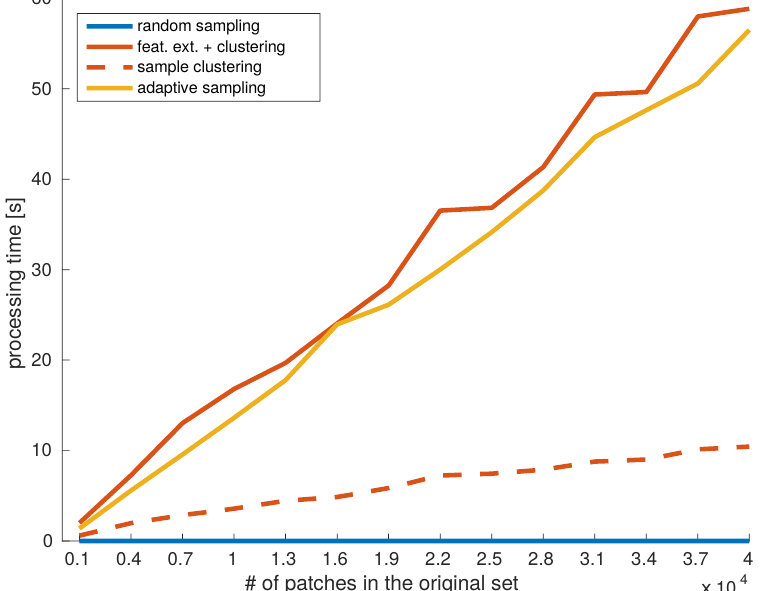
Figure 12. Time required to process and subsample an increasing number of candidate patches, by each data sampling